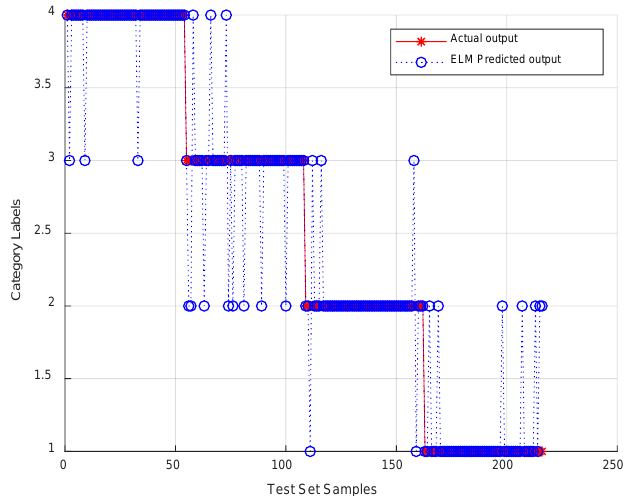
Figure 8. ELM (100 nodes)-based fatigue state detection results.